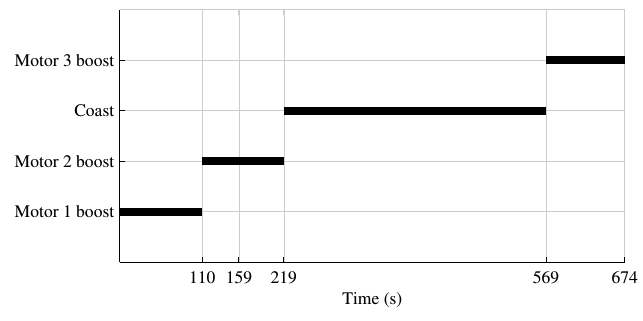
Figure 3. Mission phase